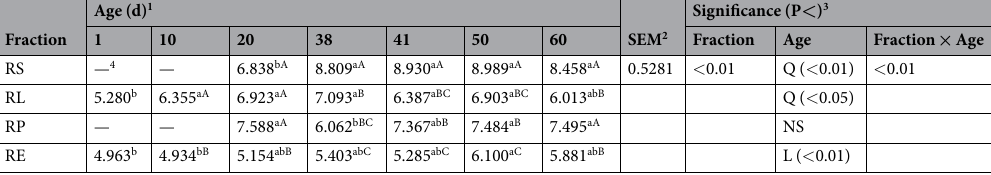
Table 1. Change of methanogen copy number (Log 10 copies/ μ L cDNA) in four fractions during rumen development a,b . Means within a row for days that do not have a common superscript differ (P < 0.05); A–C Means within a column for fractions that do not have a common superscript differ (P < 0.05). 1 Samples on 50 d and 60 d were collected from goats fed the control diet; SEM 2 represents SEM for fraction × age; 3 NS = not significant (P > 0.05), L = Linear effect of age, Q = Quadratic effect of age; 4 No data due to the absence of